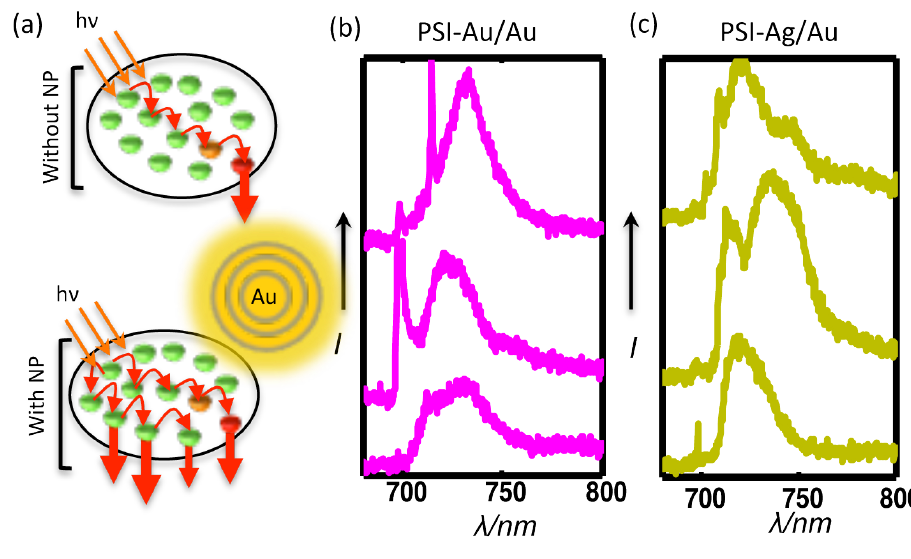
Figure 7. ( a ) A simplified illustration of the proposed mechanism for